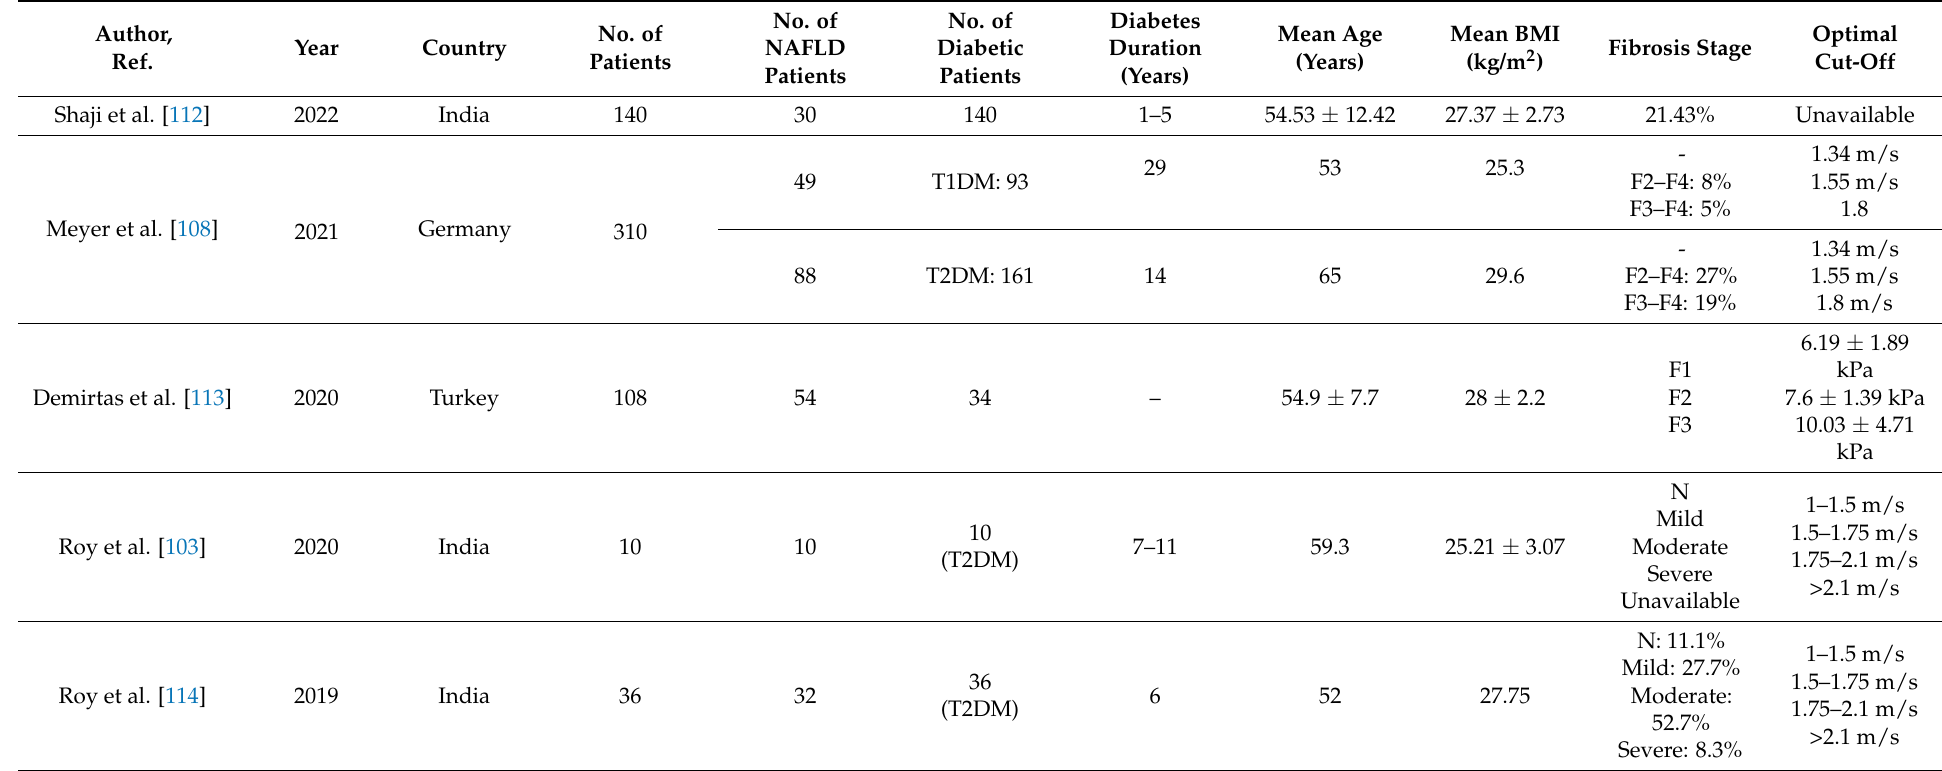
Table 2. Diagnostic performance and comparison of results for different fibrosis stages using pSWE in patients with NAFLD and